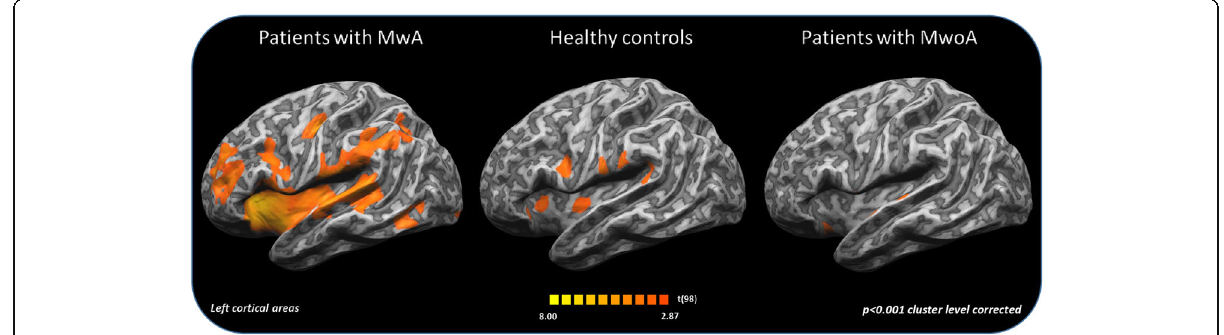
Fig. 1 Group-level (main effects) BOLD-response of advanced visual network (encompassing lingual gyrus, inferior parietal lobule, inferior frontal gyrus and medial frontal gyrus) in patients with MwA, MwoA and HC during THS at 51 °C. Statistical maps were obtained overlaying an inflated 3D brain surface from the ‘ Colin 27 ’ atlas ( p < 0.001 cluster-level corrected). MwA = migraine with aura; MwoA = migraine without aura; HC = healthy